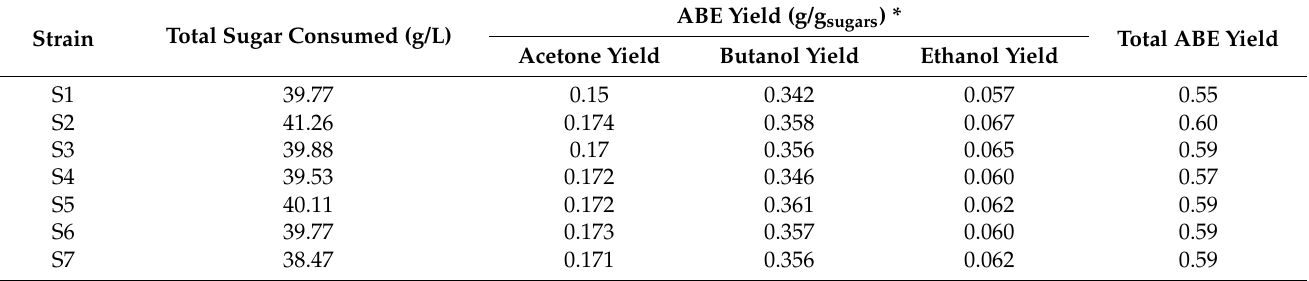
Table 2. Comparison of sugar consumption and ABE yield for all strains during SSF of WS. ABE Yield (g/g sugars ) * Strain Total Sugar Consumed (g/L) Total ABE Yield Acetone Yield Butanol Yield Ethanol